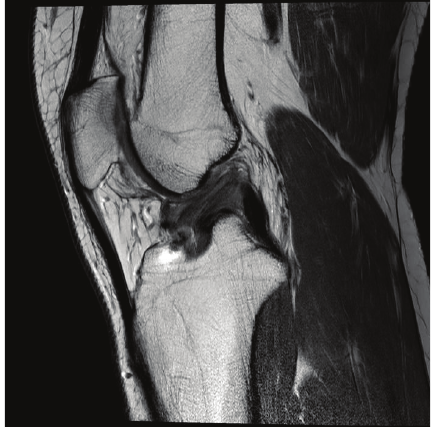
Figure 2: Preoperative sagittal MRI scan of the left knee.